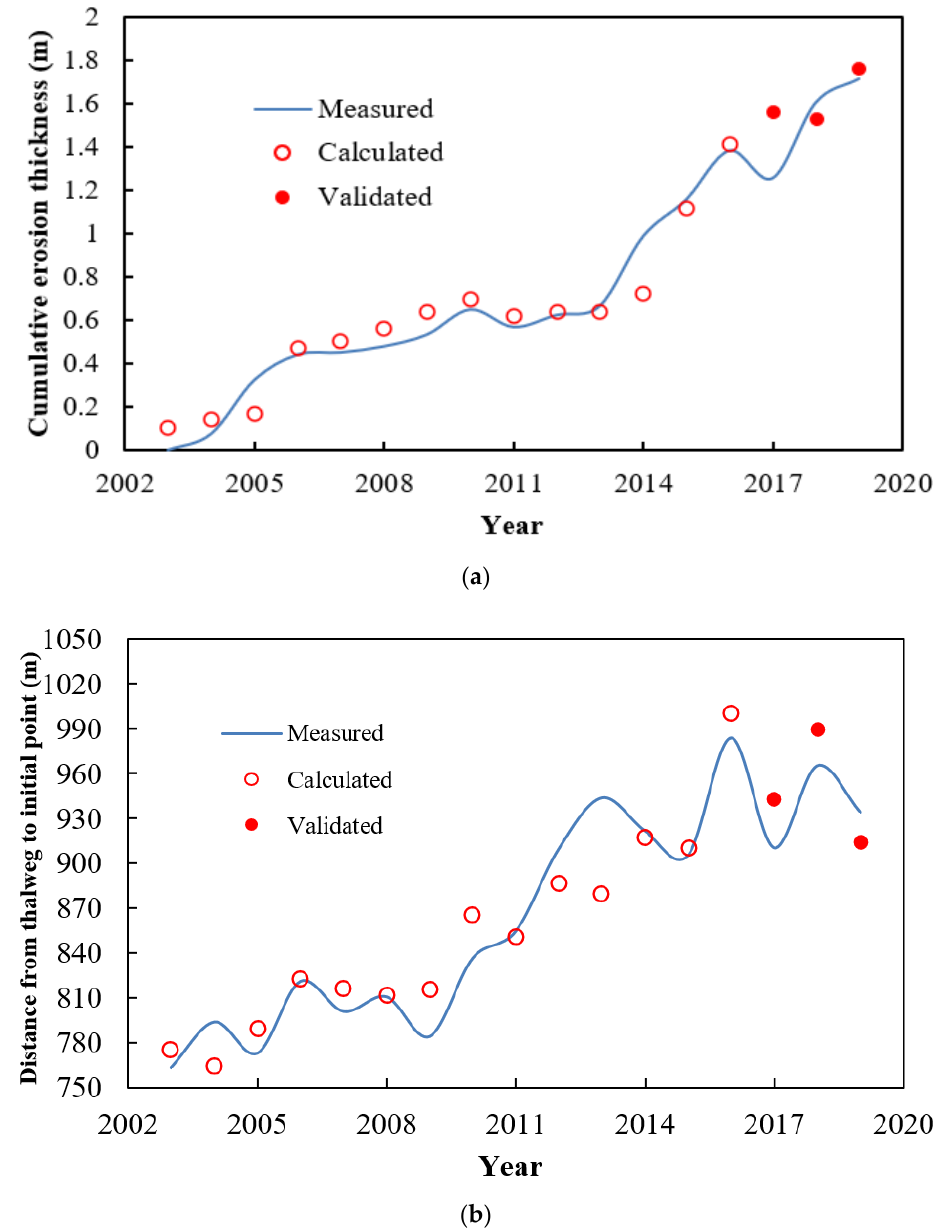
Figure 10. Comparison between the measured values of the longitudinal and lateral stability indexes of the Wuhan reach and the values calculated using the DRM. ( a ) Cumulative erosion. ( b ) Distance from the thalweg to the initial